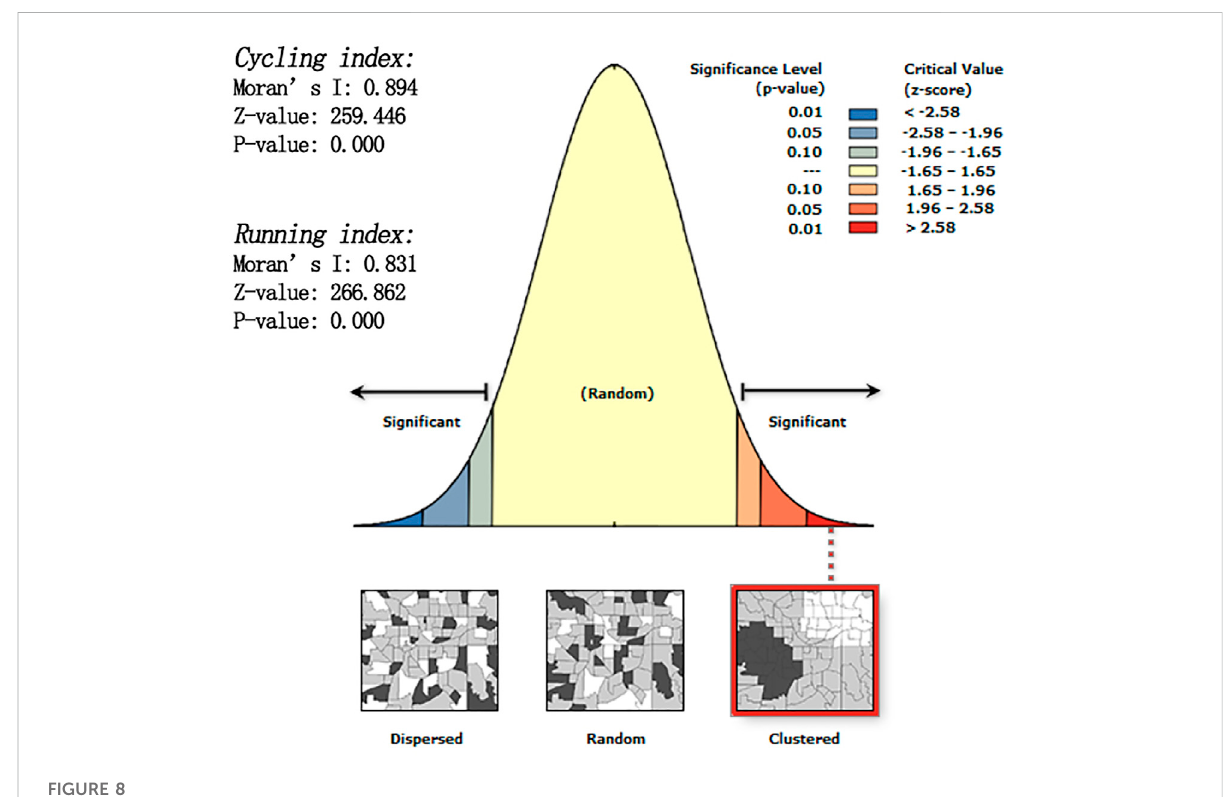
FIGURE 8 Moran ’ s index results.